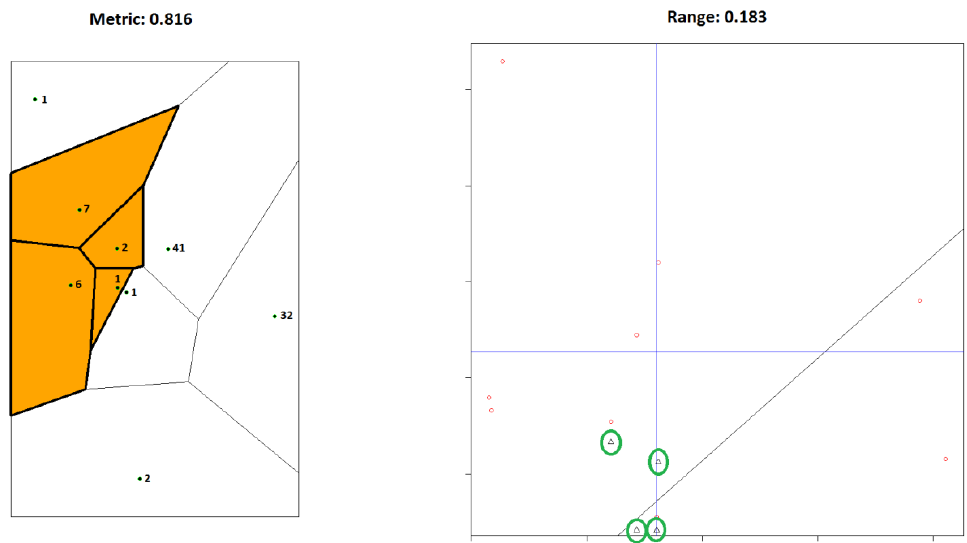
Figure 1. Voronoi tessellation created from generic test data.